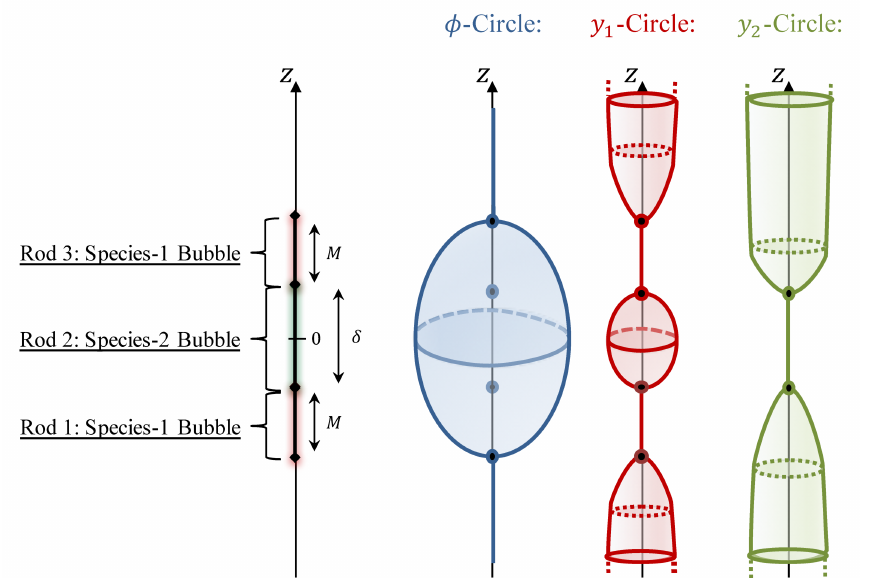
Figure 7. Rod profile of the three-bubble solutions and the behavior of the circles on the z -axis.